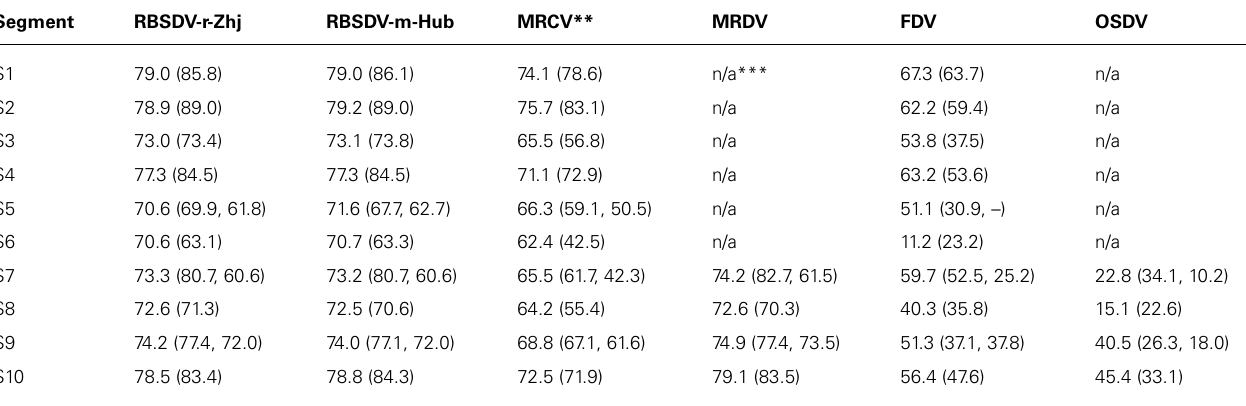
Table 1 | Identities ( % ) of nucleotide and predicted amino acid (bracketed) sequences between SRBSDV Hainan isolate and other plant-infecting fijiviruses*.